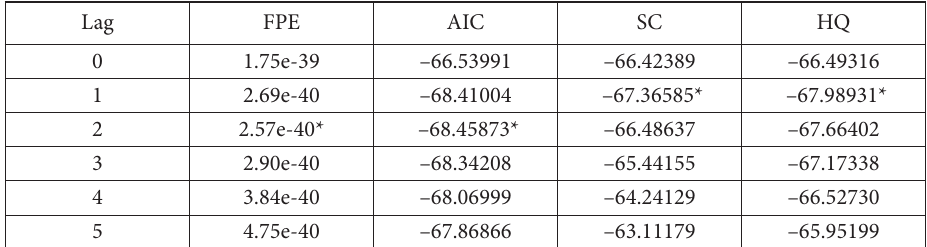
Table 2. The values of information criteria for the choice of the VAR model lag (source: Results ob- tained by the authors) Lag FPE AIC SC HQ 0